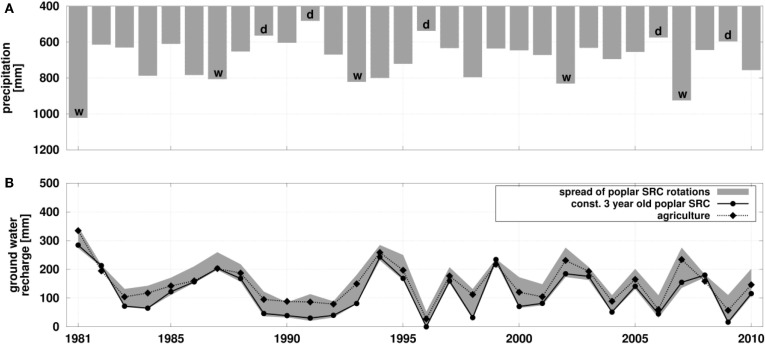
Comparison of plot model results for the two land use types agriculture and poplar SRC – with and without rotation. (A) Sums of precipitation for hydrological years (Oct–Nov), “d” marks the 5 driest years and “w” the 5 wettest years in the period 1981–2010; (B) sums of ground water recharge for hydrological years for agriculture and poplar SRC, whereas poplar SRC is kept constant in time (no rotation, 3-year-old) and the spread over simulations using a 5-year rotation period, starting in each of these 5 years.